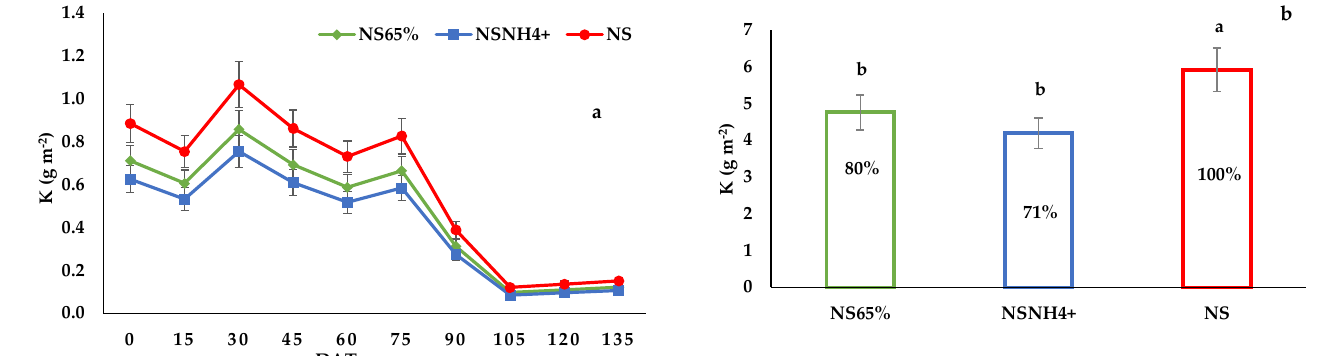
Figure 3. ( a ) Evolution of K leaching during the cultivation, ( b ) Total amount of K leached by the tomato crop, with the percentage of contamination reduction of the fertigation strategies assayed compared to the standard fertigation. The columns show the mean values, and the bars the standard deviation of each treatment ( n = 12) at the end of the trial. Different letters indicate the significant differences among treatments at the p < 0.05 level, based on the LSD